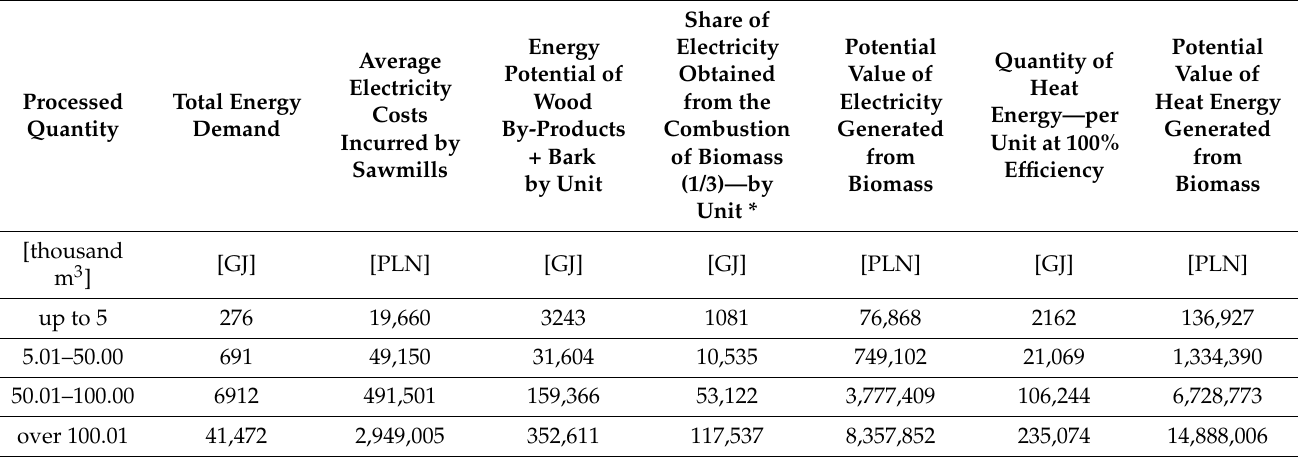
Table 11. Average energy costs incurred by sawmills per